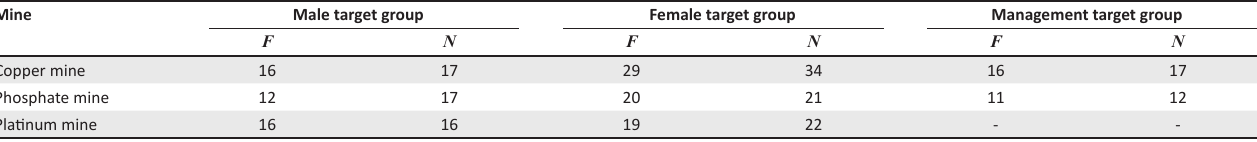
TABLE 1: Participants’ awareness of the sexual harassment policy. Mine